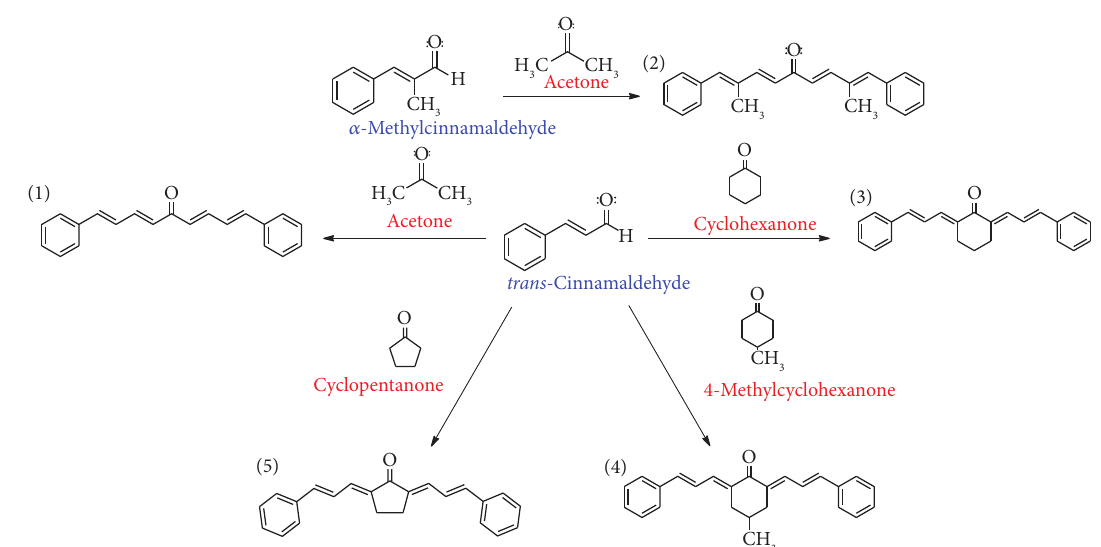
Figure 1: Five cinnamaldehyde-derived organic compounds (1–5) were synthesized with cyclic and noncyclic ketones via the aldol condensation reaction.